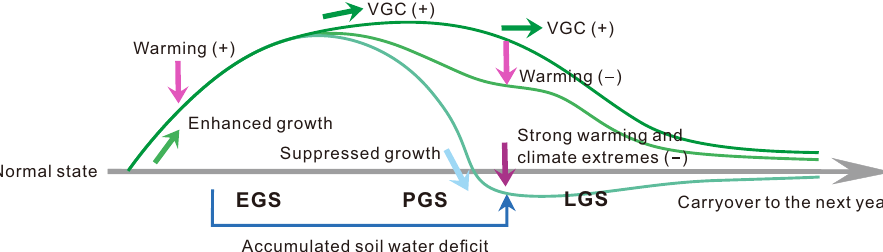
Fig. 6 Schematic representation of the vegetation growth carryover. The green curves indicate anomalies of vegetation greenness/productivity in response to climatic changes and disturbances, relative to the climatological seasonal cycle (the gray line). Early growing-season (EGS) warming stimulates extra vegetation growth and productivity, and this ecological bene fi t can persist into peak and late growing-season (PGS and LGS) and even the subsequent year because vegetation growth is largely determined by its prior states (i.e., the vegetation growth carryover, VGC). This greening signal from EGS, however, may be suppressed or even reversed for some locations due to climate extremes or soil moisture de fi cit legacy from EGS. The symbols − and + in each bracket represent either a negative or positive force respectively imposed on terrestrial